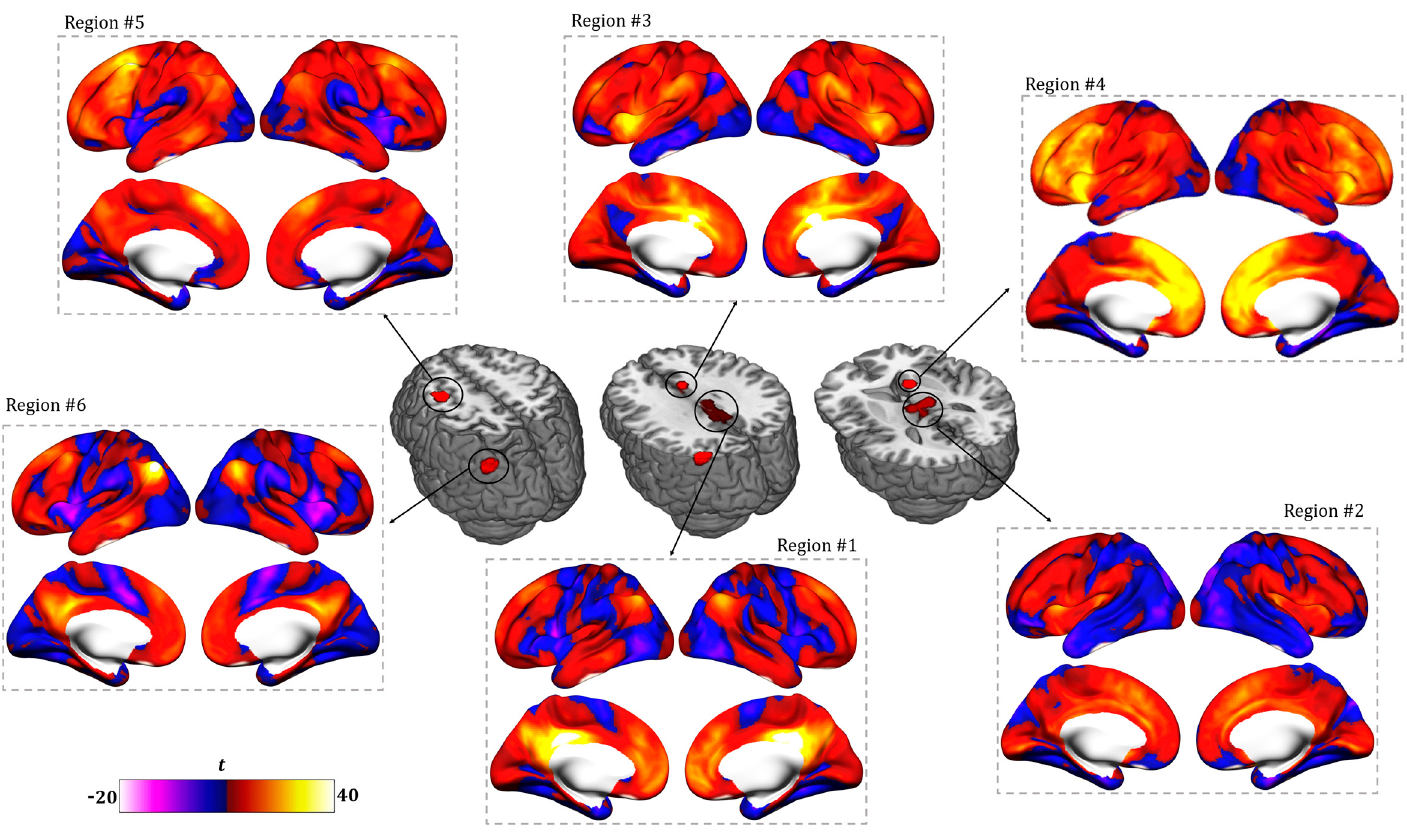
Figure 4. Network mapping. Positive and negative functional connectivity profile for each ALE region is shown. Surface representation underlies the high similarity between the functional connectivity (FC) of regions #1, #5 and #6 and between the FC of regions #2, #3 and #4.